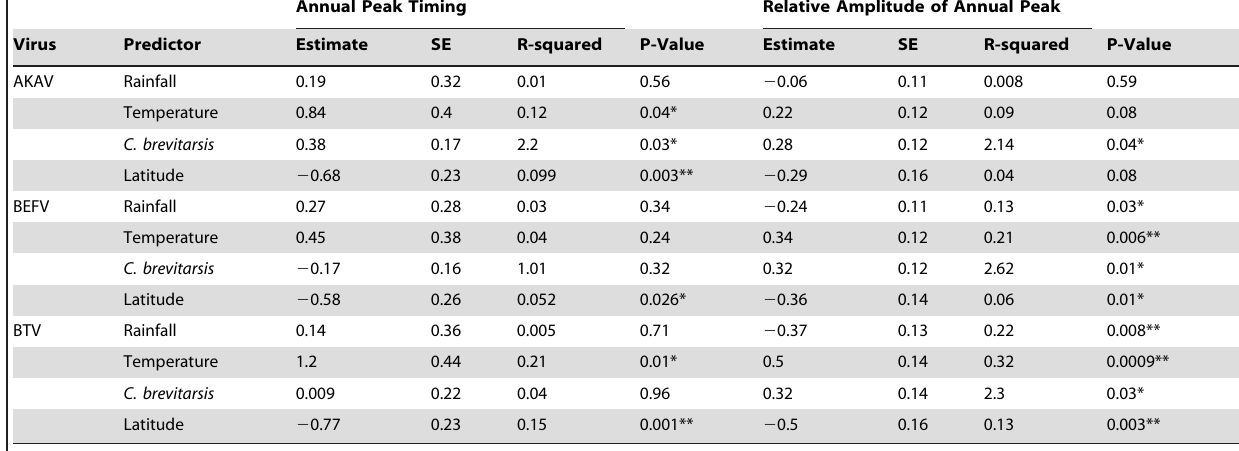
Table 1. Seasonal